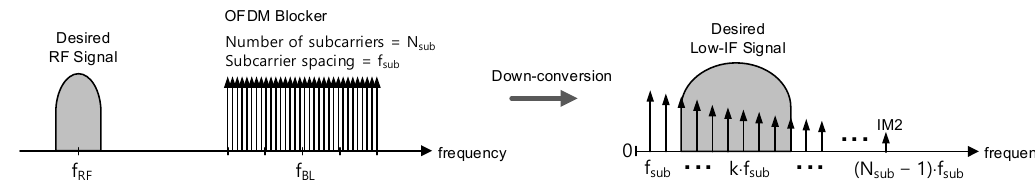
Figure 2. IM2 distortions induced by the multi-tone OFDM blocker.